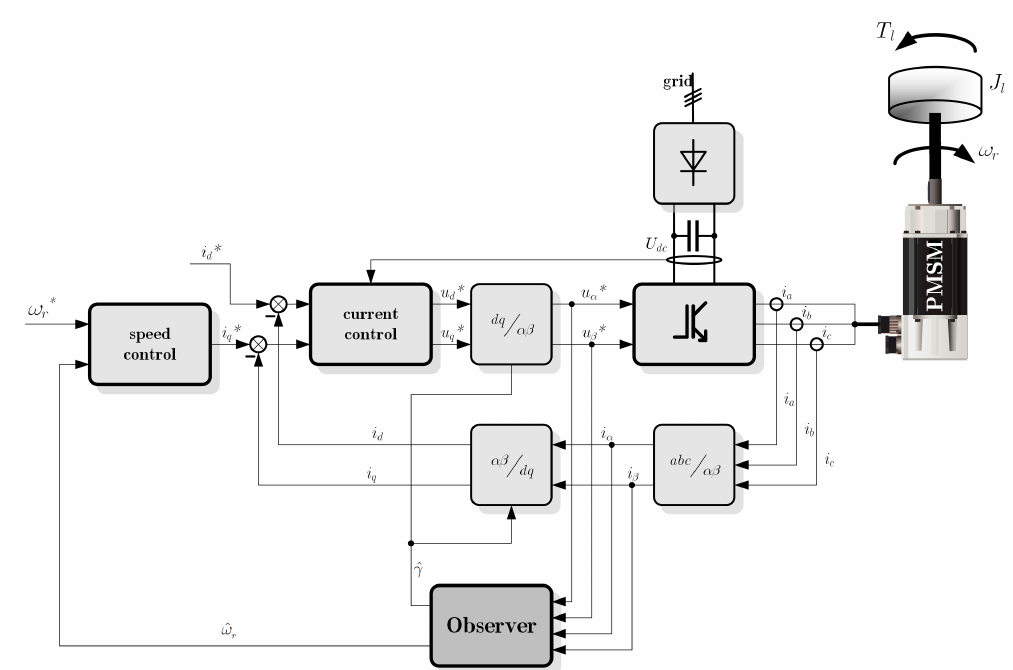
Figure 1. The proposed sensorless drive